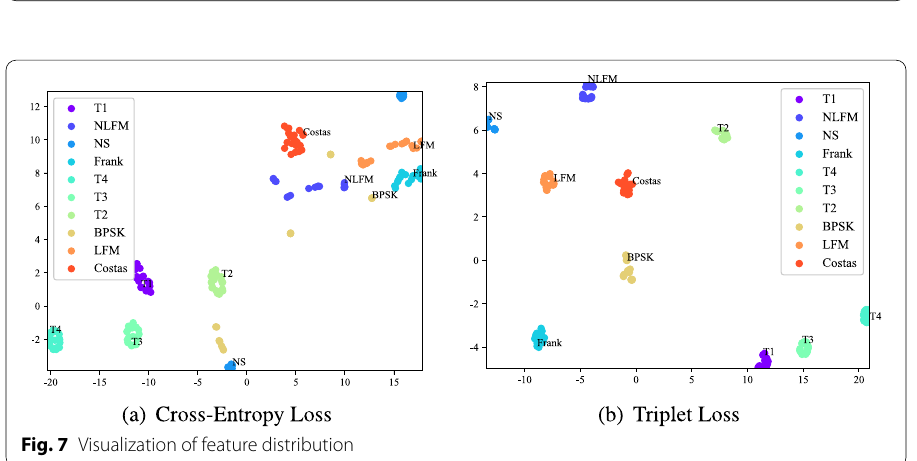
Fig. 7 Visualization of feature